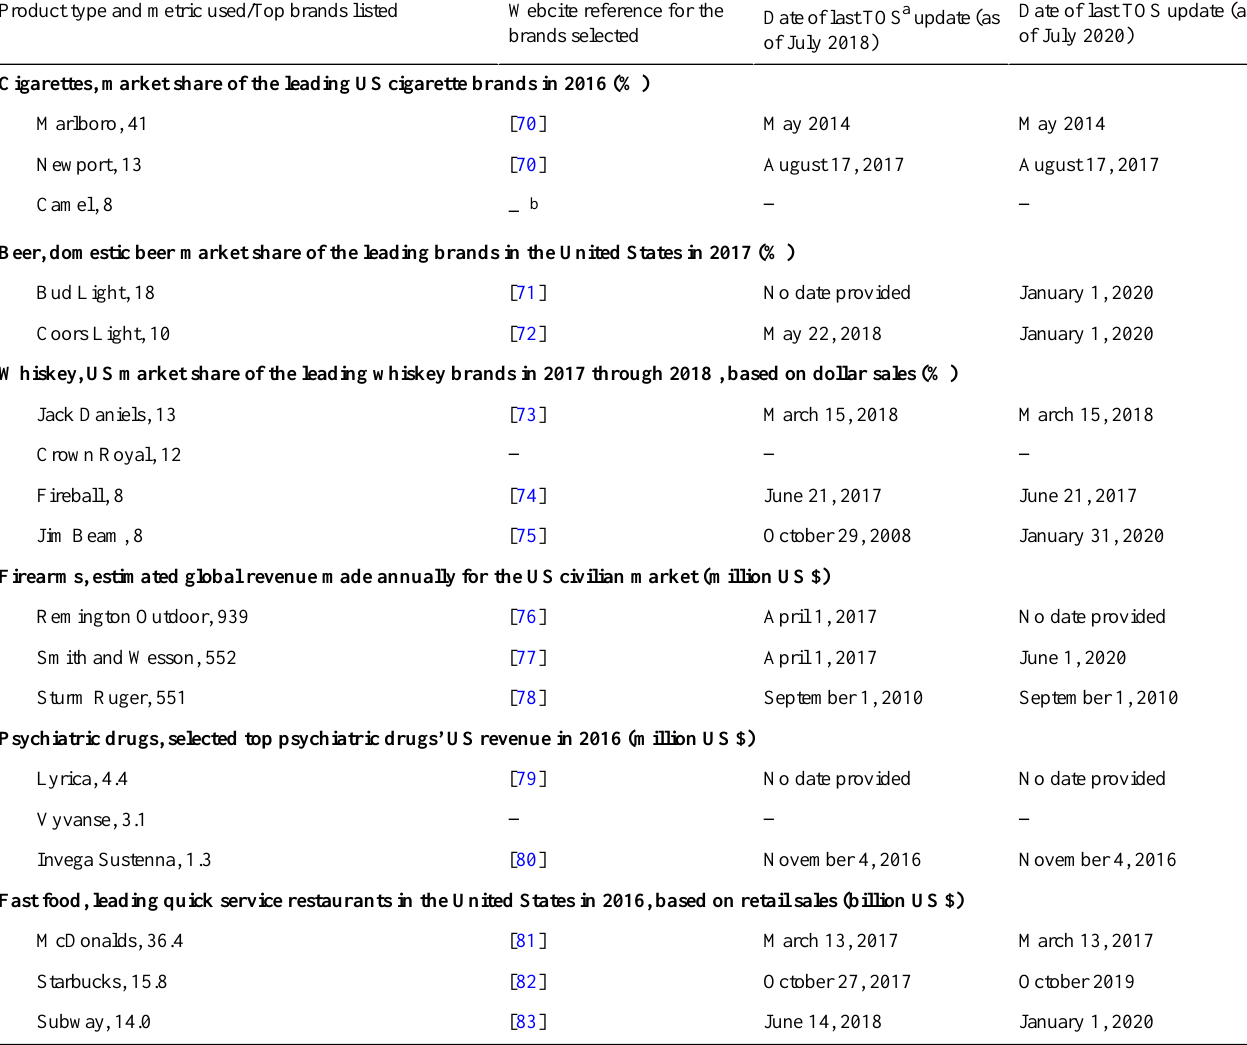
Table 1. Acquisition of website sampling using data from